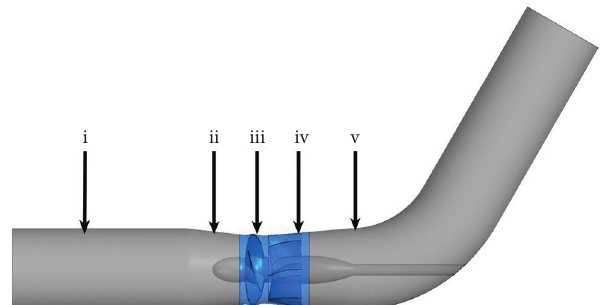
Figure 1: Axial-flow pump device model. (i) Inlet pipe. (ii) Inlet cone pipe. (iii) Impeller. (iv) Guide vane. (v) Outlet pipe.